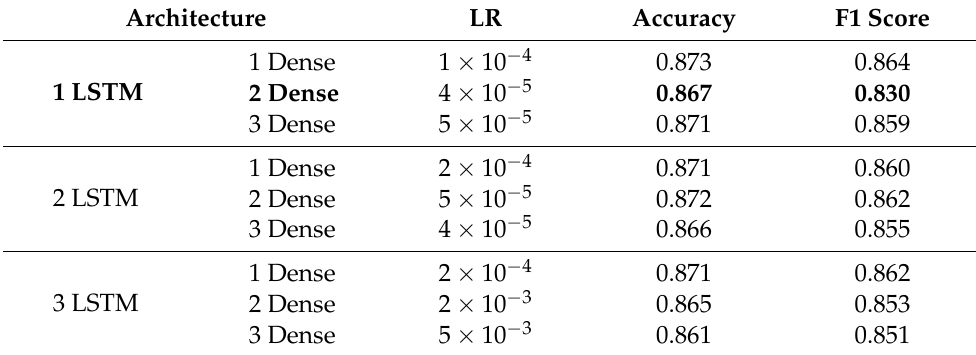
Table 10. Comparing LSTM-based classifier results using the BERT tokenizer. Architecture